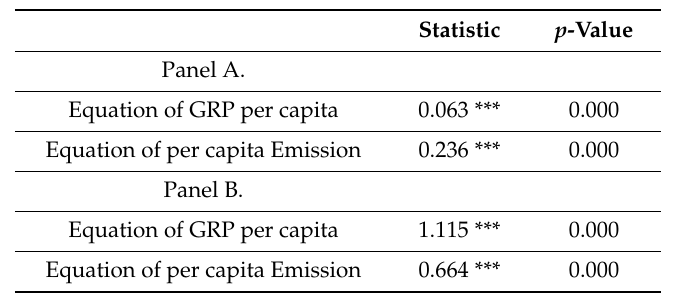
Table A3. Results of Cointegration